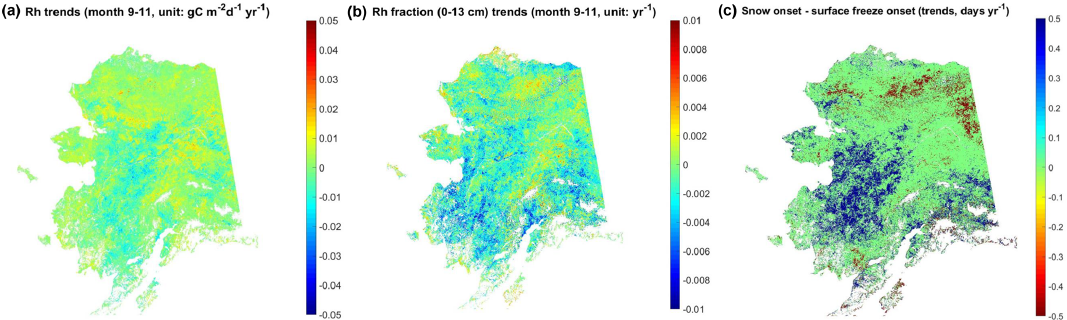
Figure 11. Regional trends of total Rh (a) and its surface soil contribution (b) during the early cold season (September–November) versus regional trends of the number of snow-free days after the land surface freezes (c) , which was defined as the difference between snow onset and surface freeze onset. Table 3. Regional mean correlation coefficient between the environmental variables and estimated surface (0–13cm) soil contribution to total Rh during the early cold season (September to November). Unless indicated, the variables were calculated during the same period as the Rh fraction. GPP LST SNOD Freeze onset Snow onset Snow onset–freeze onset Total Rh 0.33 (0.27 a ) 0.15 0.24 b 0.36 − 0 . 22 − 0 . 48 Rh fraction (0–13cm) 0.13 ( − 0 . 10 a ) 0.01 0.22 b 0.33 − 0 . 21 − 0 .